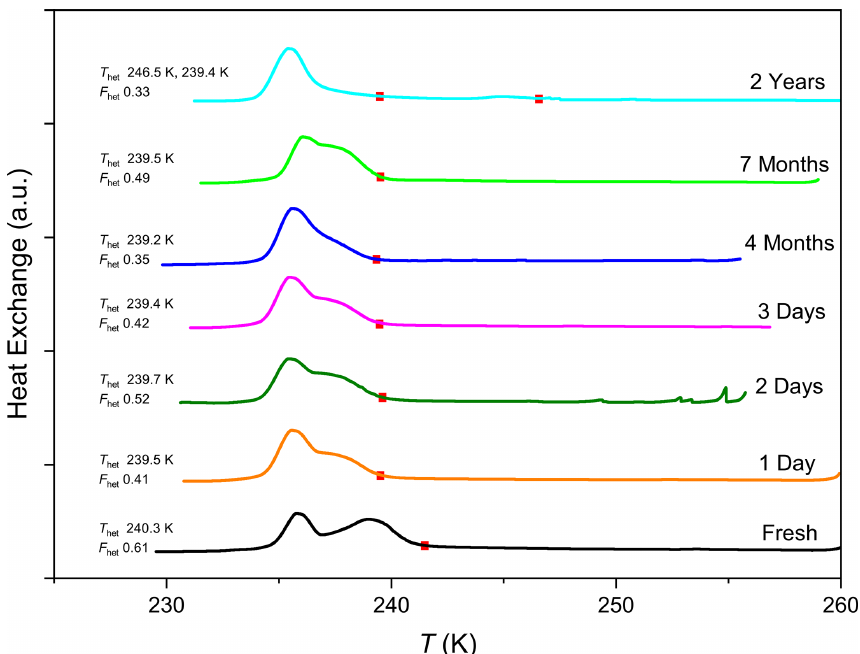
Figure 5. DSC thermograms of original STx-1b suspended in water and measured directly after preparation (fresh) and on the displayed days. Filled red squares mark the heterogeneous freezing onset temperatures ( T het ). All curves are normalized with respect to the total areas under the heterogeneous and homogeneous freezing